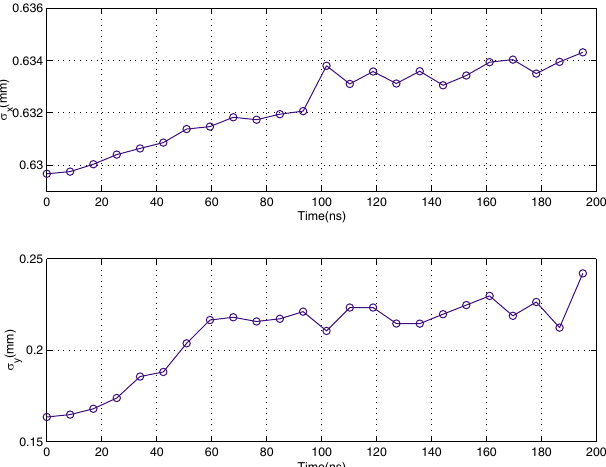
FIG. 34. Bunch shape deformation due to the interaction with electron cloud without (left) and with synchrotron motion (right) obtained from a microbunch simulation for KEKB [28]; posi- tions of microbunches are plotted after 100 turns for an electron density of 10 12 m (cid:2) 3 ; the synchrotron tune for the right case is (cid:3) 0 : 015 . Q s